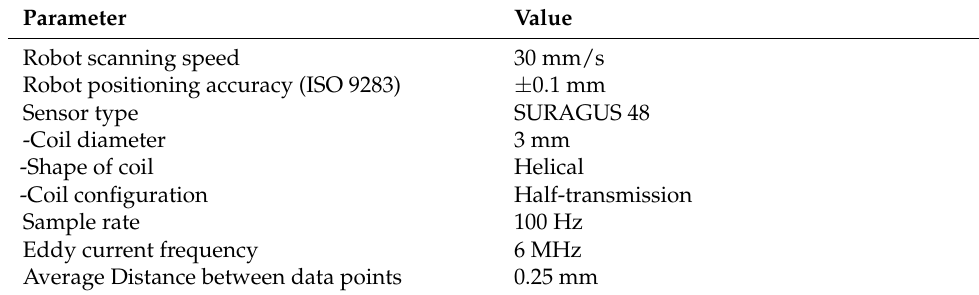
Figure 3. Photographs of the Kuka-iiwa collaborative robot equipped with the EddyCus EC sensor. The result of the rasterised scan operation is a 2D map of the sample’s electrical conductivity relative to the orientation of the sensor head during the scan. By rotating the EC sensor and performing repeated scan operations, it is possible to combine the electrical conductivity maps, to calculate variations in uniformity and main fibre orientation. Therefore, four repeated scan operations were performed for each region, and for each scan, the sensor orientation was changed from − 45 ◦ to 90 ◦ , in 45 ◦ increments. Table 1 summarises the scanning parameters for the experiments, including the errors in measurements. Table 1. Eddy current scanning parameters for the